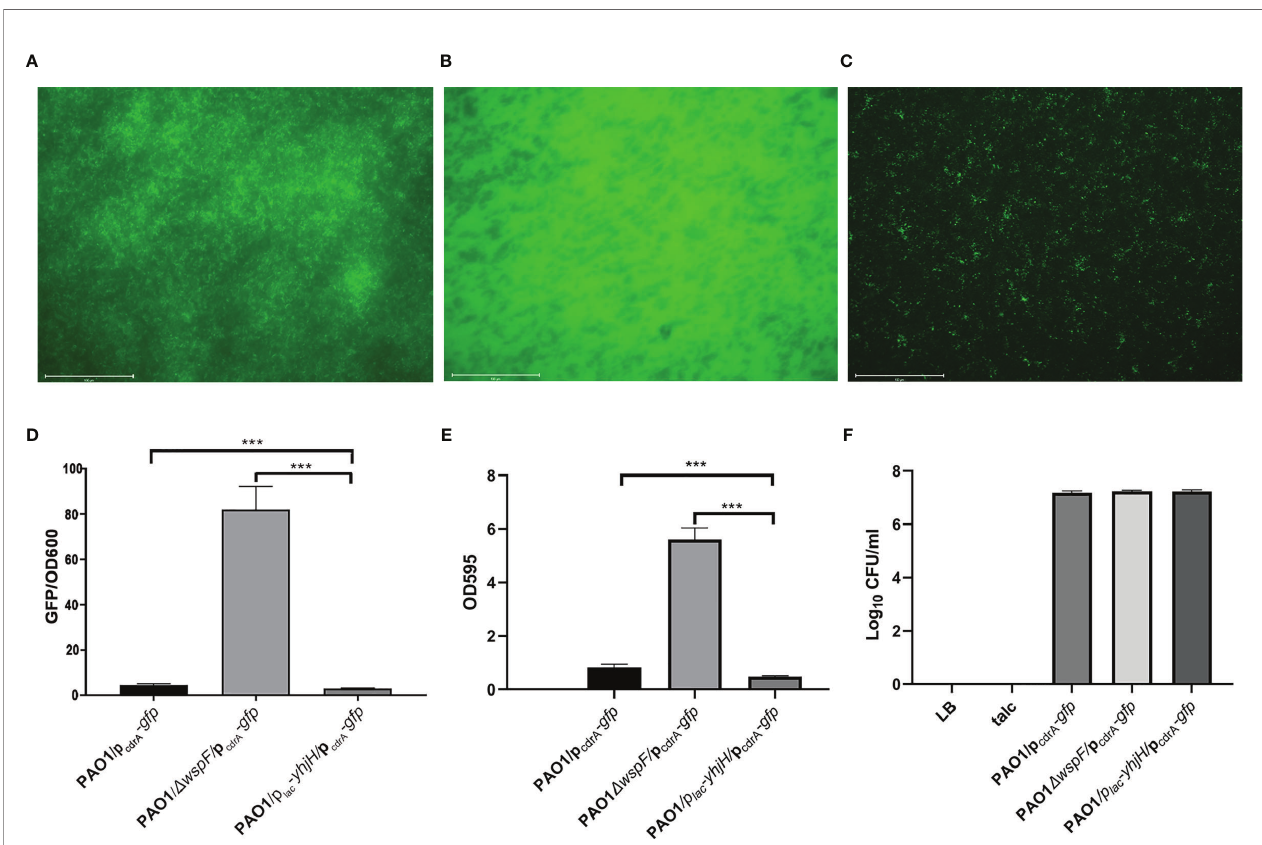
FIGURE 2 | Comparison of c-di-GMP content measurement, bio fi lm formation in vitro , and the fi brinous deposition colony count in vivo . (A) The expression of p cdrA - gfp in bio fi lm in the PAO1 group. (B) The expression of p cdrA -gfp in bio fi lm in the PAO1 D wspF group. (C) The expression of p cdrA -gfp in bio fi lm in the PAO1/p lac -yhjH group. (D) Comparison of c-di-GMP content measurement in the three infection groups. The optical densities of 600 nm (OD600) and green fl uorescent protein (GFP) fl uorescence (in relative fl uorescence units) (emission wavelength 535 nm; excitation wavelength 485 nm) were recorded. (E) Comparison of bio fi lm formation in the three infection groups. (F) Comparison of the fi brinous deposition colony count in vivo . Results are represented as the mean ± SD. *** p < 0.001. ANOVA test was used to compare group differences. (600 × 600 DPI). LB, Luria – Bertani; talc, magnesium